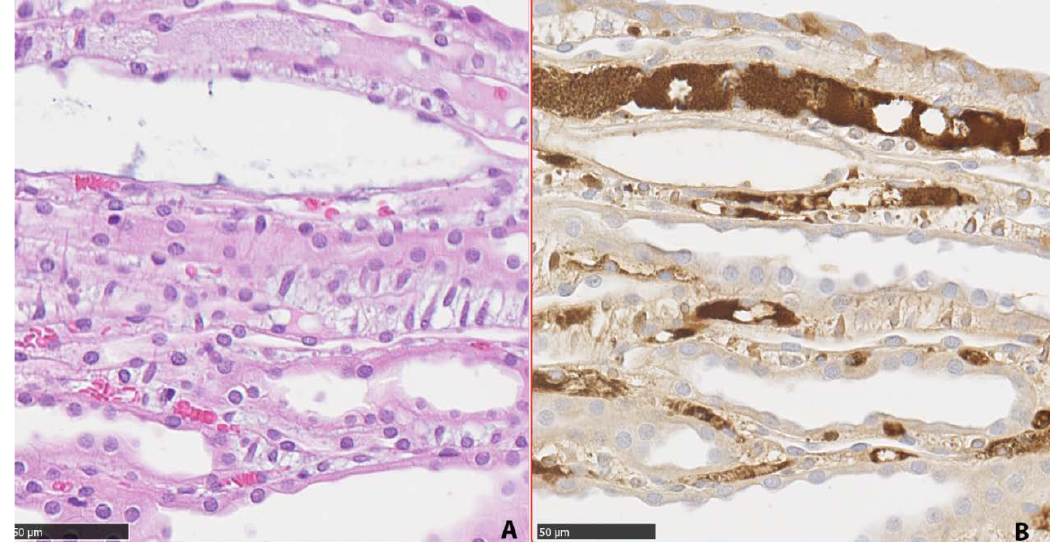
Figure 3. Closely matching longitudinal sections through renal papilla stained with haematoxylin and eosin ( A ) or for p-S6 protein ( B ) correlating stained areas, probably vascular (note erythrocytes), between some ducts a nd tubules. Bar 50